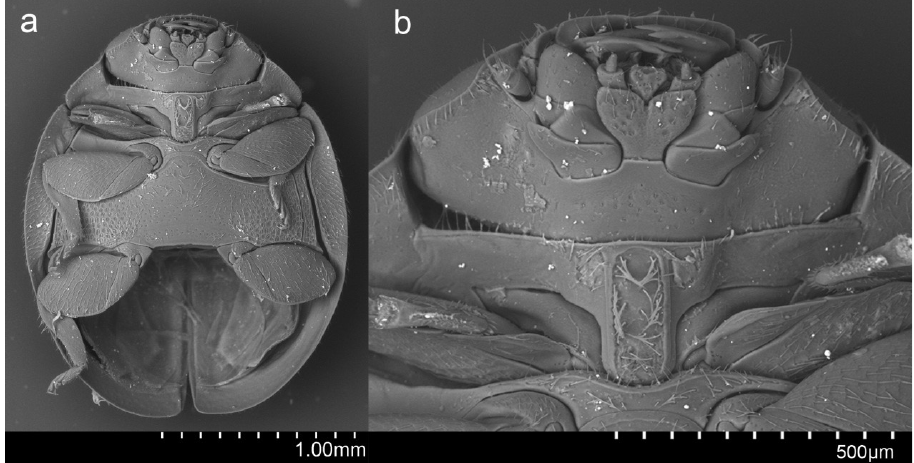
Figure 2. Pseudaspidimerus palatus Huo et Wang sp. n. a ventral view b prosternum and mouth part.